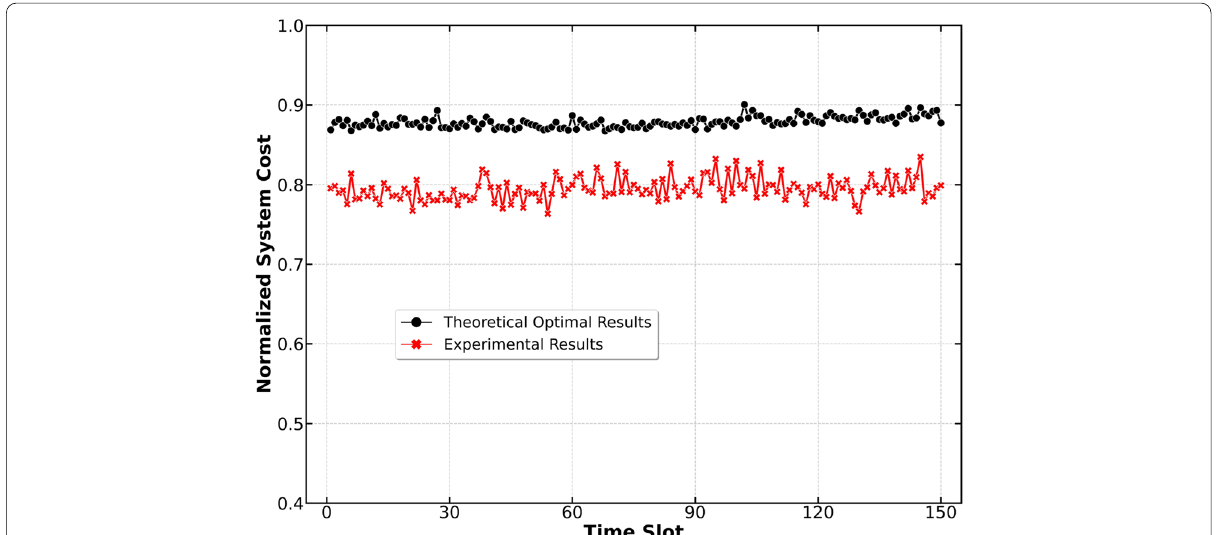
Fig. 6 Performance gap between the proposed CMATD3 and the theoretical optimal